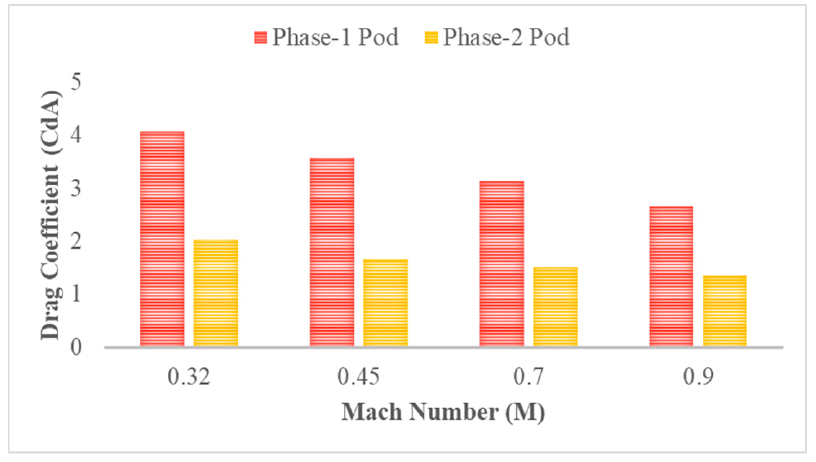
Figure 7. Drag coefficients for the pod models.